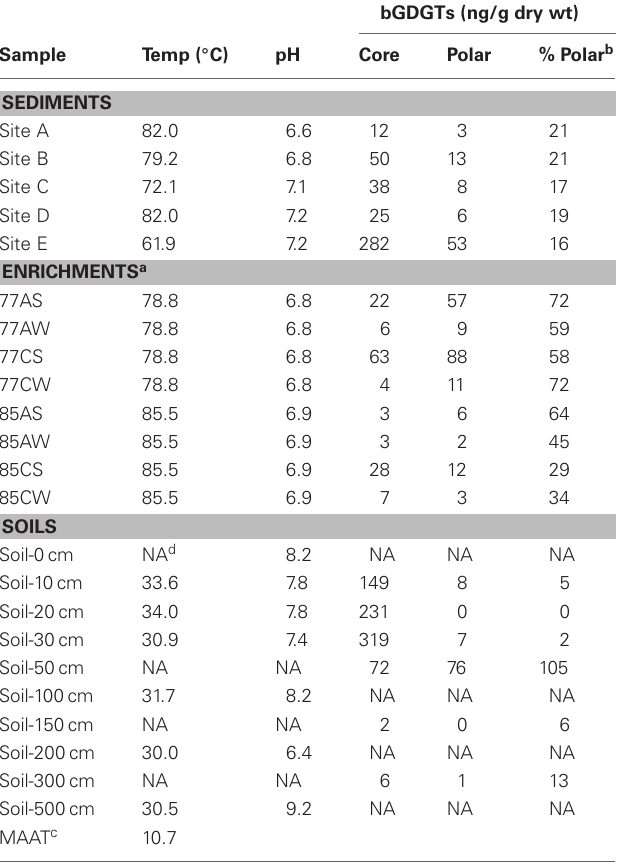
Table 1 | Core- and hydrolysis-derived polar bGDGTs from sediments, in situ cellulose enrichments in GBS, and soil samples along a transect from the hot spring (Figure 1).